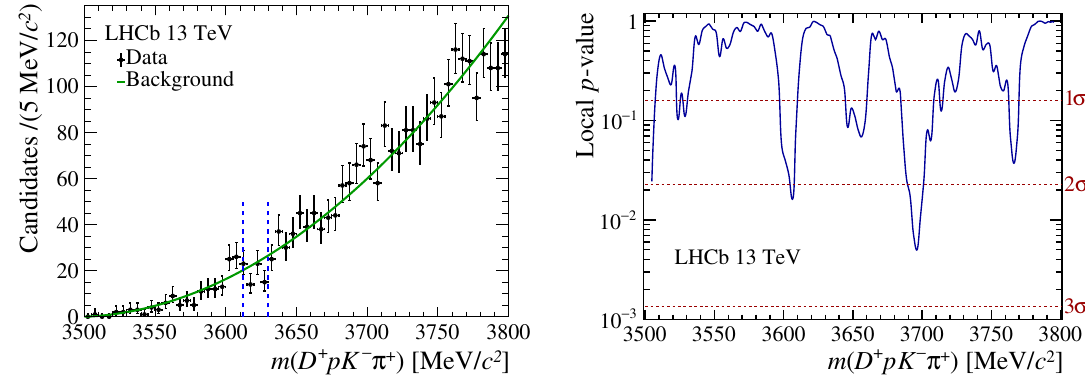
Figure 3 . (Left) Invariant-mass distribution of the (cid:4) ++ D + pK (cid:0) (cid:25) + candidates with the (cid:12)t cc ! overlaid. The black points represent data, the continuous (green) line represents the combinatorial background and the two vertical parallel dashed (blue) lines de(cid:12)ne the region where the signal is expected. (Right) The local p -value expressing the compatibility of the data with the background- only hypothesis. The horizontal dashed (red) lines indicate p -values of 1, 2 and 3 (cid:27) local signi(cid:12)cance.